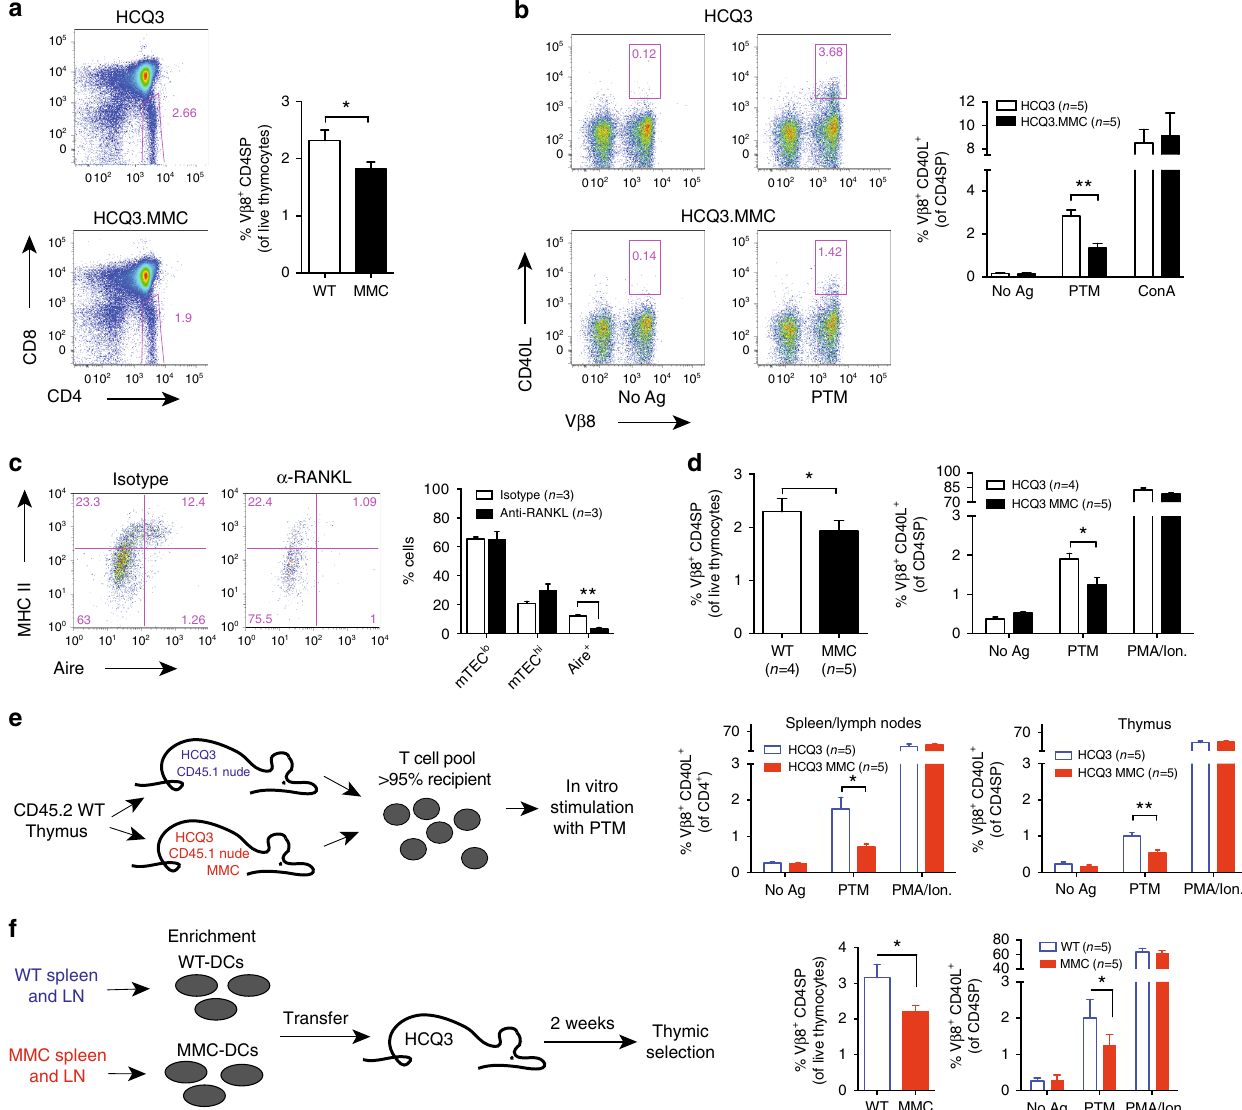
Fig. 5 Peripheral antigen migration mediates thymic tolerance to the PTM epitope. Frequency of (a) CD4 single-positive and (b) CD4 + CD40L + thymocytes from naive HCQ3 and HCQ3.MMC mice, after antigen stimulation in vitro. Cells left unstimulated (No Ag) or concanavalin A (ConA) stimulated were used as negative and positive controls, respectively. c Treatment with anti-RANKL antibody induces selective depletion of Aire-expressing mTECs in the thymus. Indicated number of mice was treated with 100 μ g of anti-RANKL or an isotype control antibody every second day for 2 weeks, and thymi were collected and analyzed the following week. Dot plots show representative examples of outcome following antibody treatment. d Treatment with anti-RANKL antibody does not alter central tolerance of HCQ3 transgenic T cells in HCQ3.MMC mice as determined by frequencies of CD4SP thymocytes (left) or up- regulation of CD40L following ex vivo stimulation with the PTM CII 260 – 270 peptide. Cells cultured in the absence of antigen (No Ag) and in the presence of PMA/ionomycin (PMA/Ion) were used as negative and positive controls, respectively. e Three- to four-week-old HCQ3-nude and HCQ3.MMC-nude mice were grafted with neonate thymus from wild-type mice. Thymus and pooled spleen and lymph nodes from individual mice were recovered 14 – 21 weeks after transplantation, when recipient-derived T cells constituted > 95% of the peripheral T cell pool (as determined by CD45.1 expression) and investigated for up-regulation of CD40L, as described in d . f CD11c + cells were enriched from spleens and lymph nodes of naive MMC or WT donors and transferred to the indicated number of naive HCQ3 mice. Two weeks later, recipient mice were sacri fi ced and thymocytes were prepared and investigated ex vivo for frequency of CD4SP cells (left) and up-regulation of CD40L, as described for in d . Data from two pooled experiments are shown. p values were calculated by unpaired t test. * p < 0.05; ** p < 0.01. Gating strategies used for analysis of fl ow cytometry data are shown in Supplementary Fig.